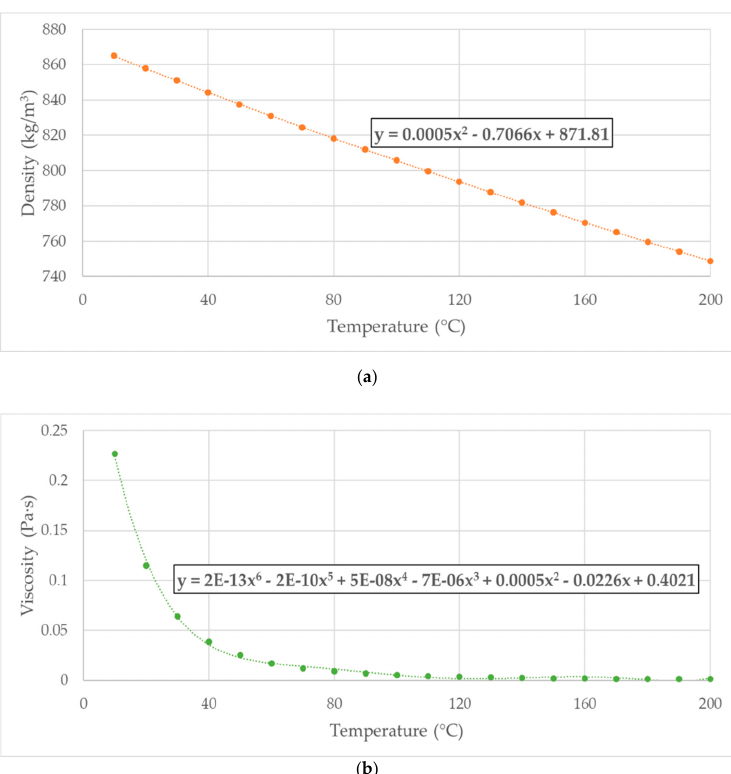
Figure 8. Mineral oil properties: ( a ) density vs. temperature; ( b ) viscosity vs.